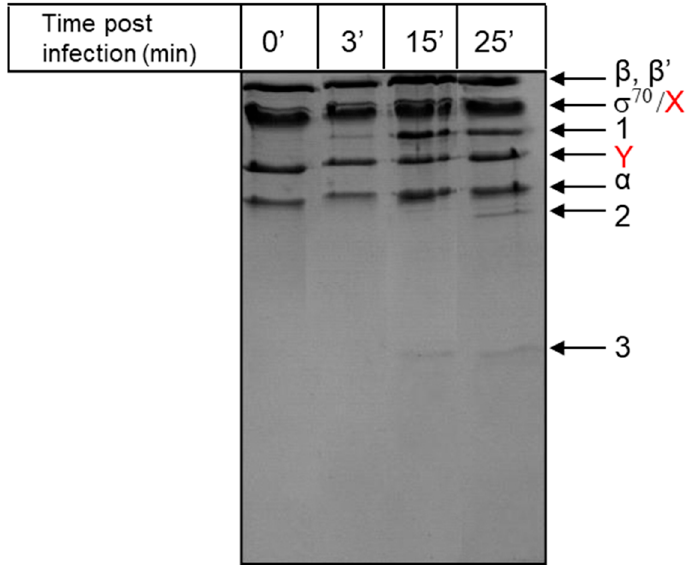
Figure 2. E. coli RNA polymerase (RNAP) purified at di ff erent stages of infection by bacteriophage T5. RNAP from uninfected cells (0) and at 3, 15, and 25 min post-infection was analyzed by SDS-PAGE electrophoresis and stained with Coomassie G-250. RNAP core subunits α (40 kDa), β (150 kDa), and β ’ (155 kDa); the σ 70 subunit (apparent molecular weight 90 kDa); contaminating proteins X and Y (highlighted in red color font); and proteins present only in preparations of RNAP purified from infected cells, marked as 1, 2, and 3, are